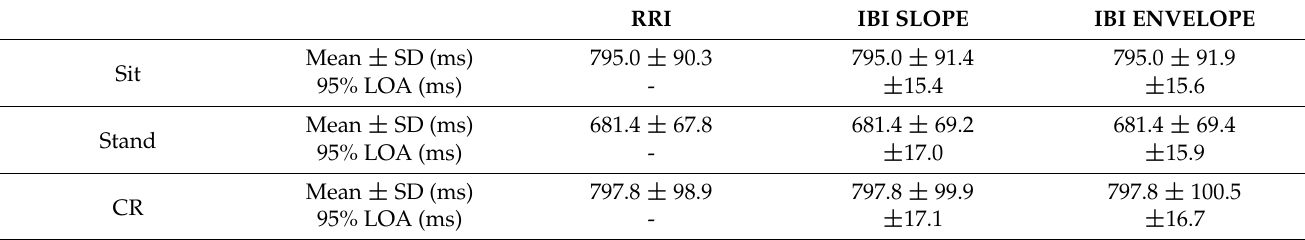
Table 3. Mean and standard deviation of the IBIs derived through ENVELOPE and SLOPE ap- proaches; 95% limits of agreement (LOA) calculated between RRIs and each series of IBIs. Assessment performed with PPG signals sampled at 64 Hz. RRI IBI SLOPE IBI ENVELOPE 795.0 ±